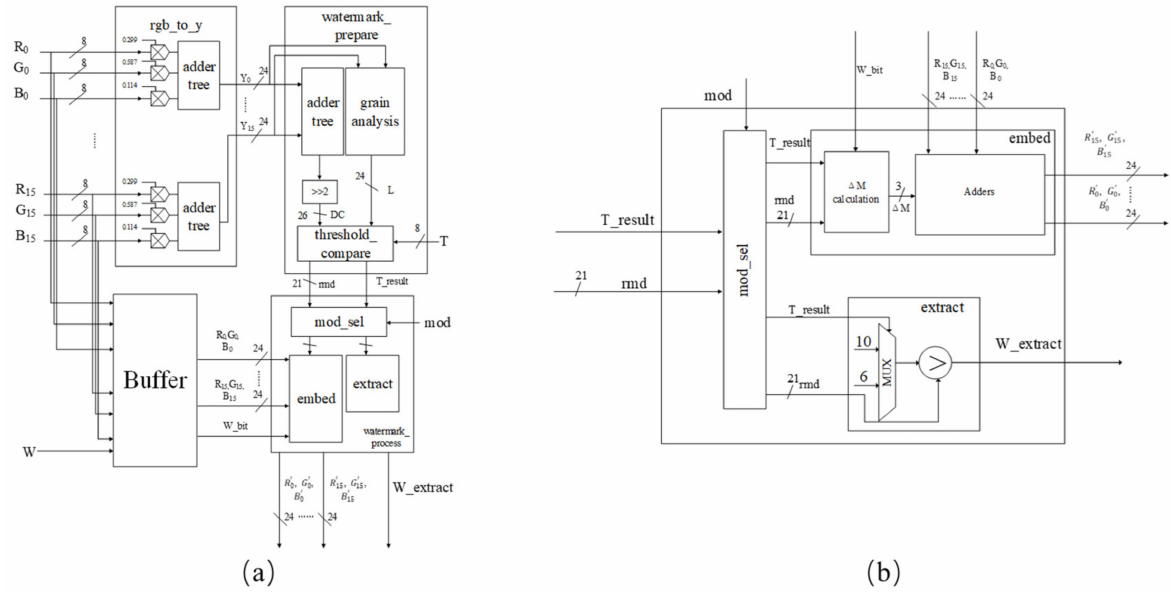
Figure 7. ( a ) Architecture of the proposed approach for a 1/16 embedding ratio. ( b ) A detailed diagram of the water- mark_process